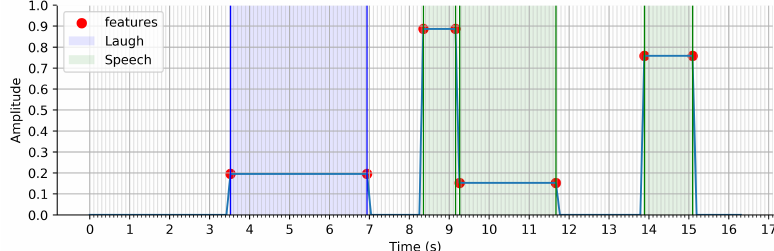
Figure 10. Fusion between event segmentation and event recognition.